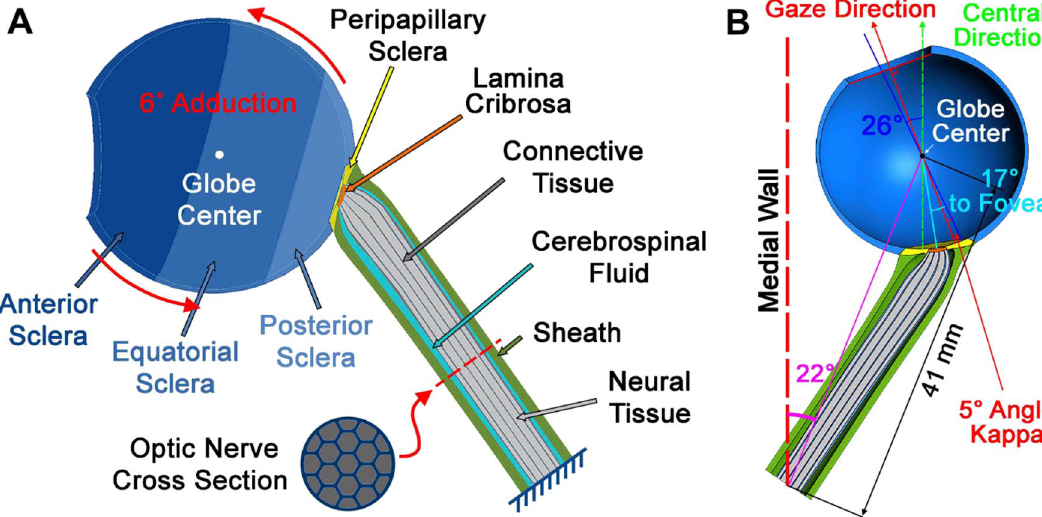
Figure 6. Model geometry. ( A ) Sclera is parsed into anterior, equatorial, posterior (blue) and peripapillary regions (yellow). The lamina cribrosa (orange) abuts the peripapillary sclera. The posterior lamina cribrosa is joined to the ON (gray), and the ON sheath (green) is joined to the peripapillary sclera anteriorly, and to the orbital apex posteriorly as boundary conditions. Cerebrospinal fluid (CSF) is shown in light blue. ( B ) Dimensions of the